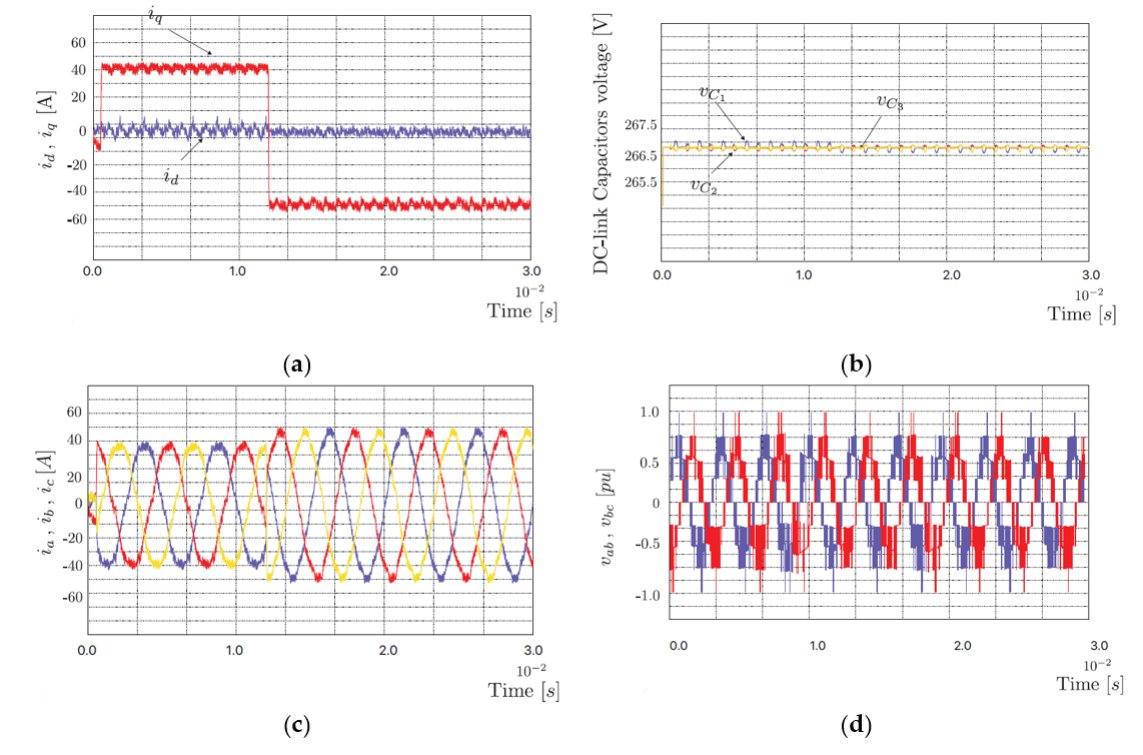
Figure 7. Simulation results for current reference step inversion using the MPC control scheme: ( a ) d q stator currents, ( b ) dc-link capacitor voltages, ( c ) load three-phase currents, ( d ) line–line voltages v ab , v bc .